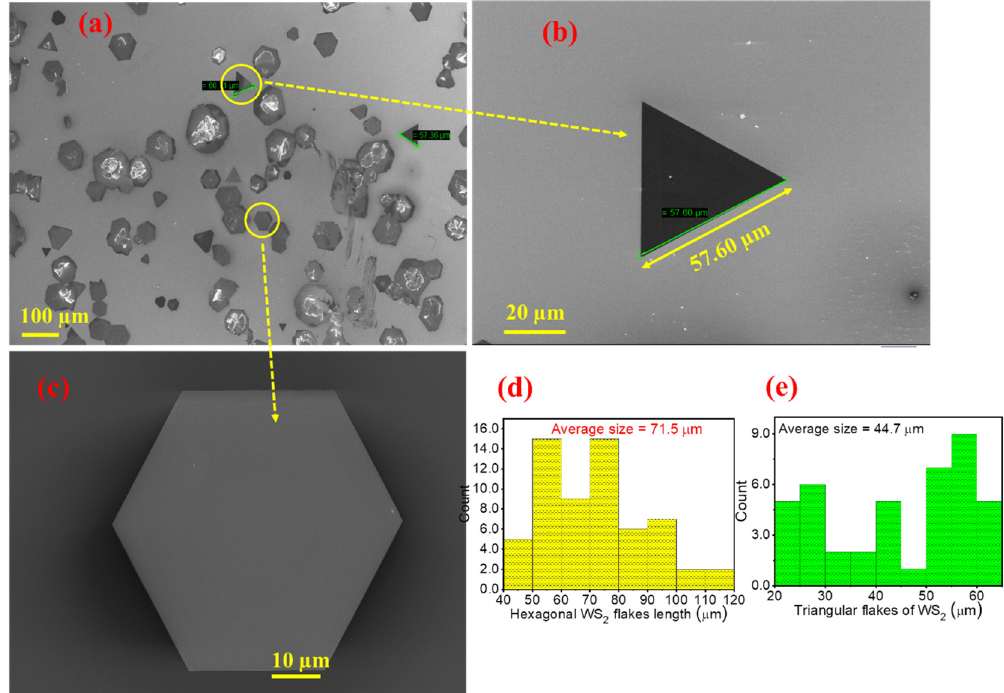
Figure 2. ( a – c ) FESEM micrographs of the WS 2 layers grown on Si/SiO 2 substrate at various magnification levels and ( d , e ) Size distribution histogram of hexagonal and triangle WS 2 flakes.